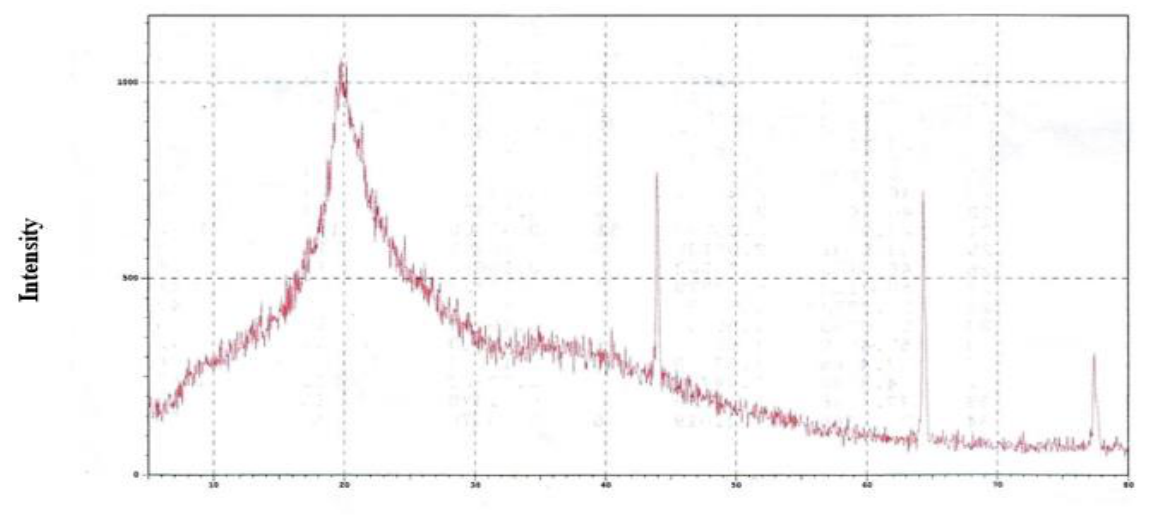
Figure 10. PXRD diffractogram of PM